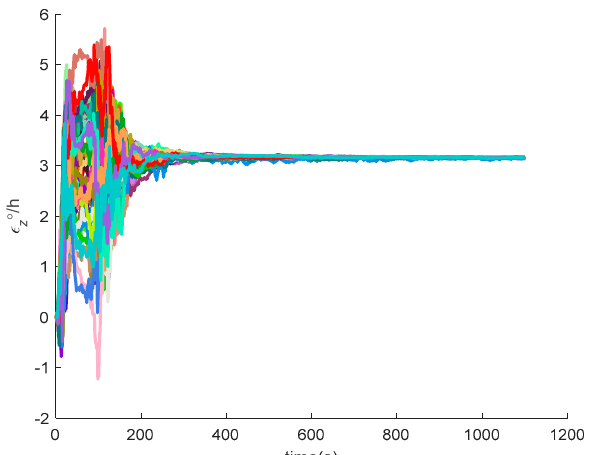
Figure 26. The y -axis gyroscope constant drift of SINS/GPS in the LCEF frame.